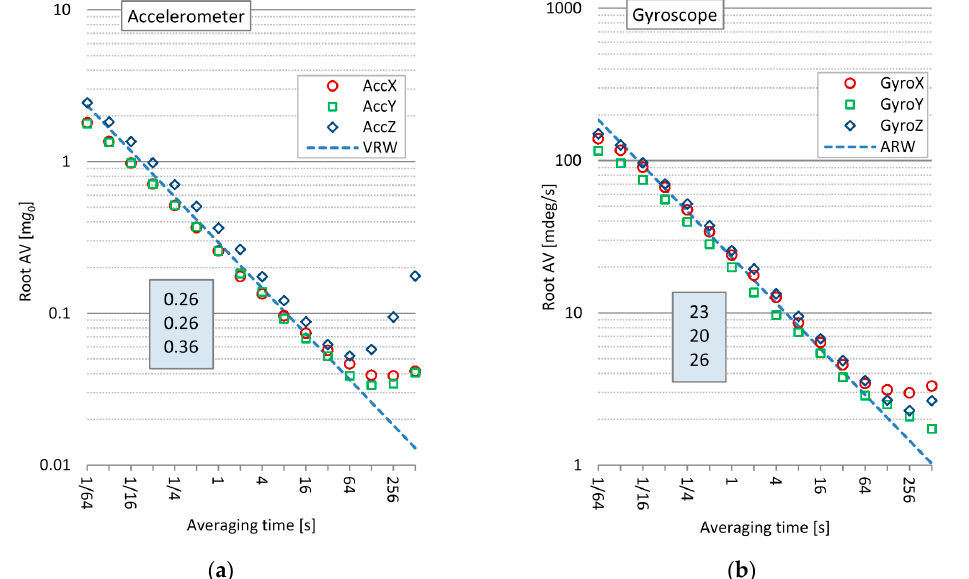
Figure 4. Allan variance measurements for all three axes of the accelerometer and gyroscope of a single smartphone as a function of averaging time in seconds. The dotted line represents the white noise model: ( a ) Accelerometer results conform to the VRW model at short averaging times; ( b ) Gyroscope results conform to the ARW model at short averaging times. Values in rectangles represent Allan deviation at averaging time of 1 s.